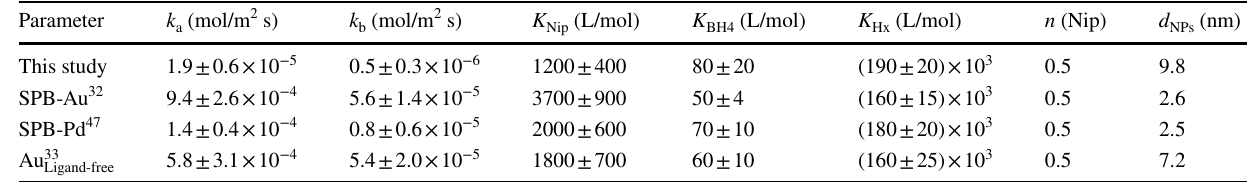
Table 1 Summary of the kinetic and thermodynamic parameters of the kinetic analysis